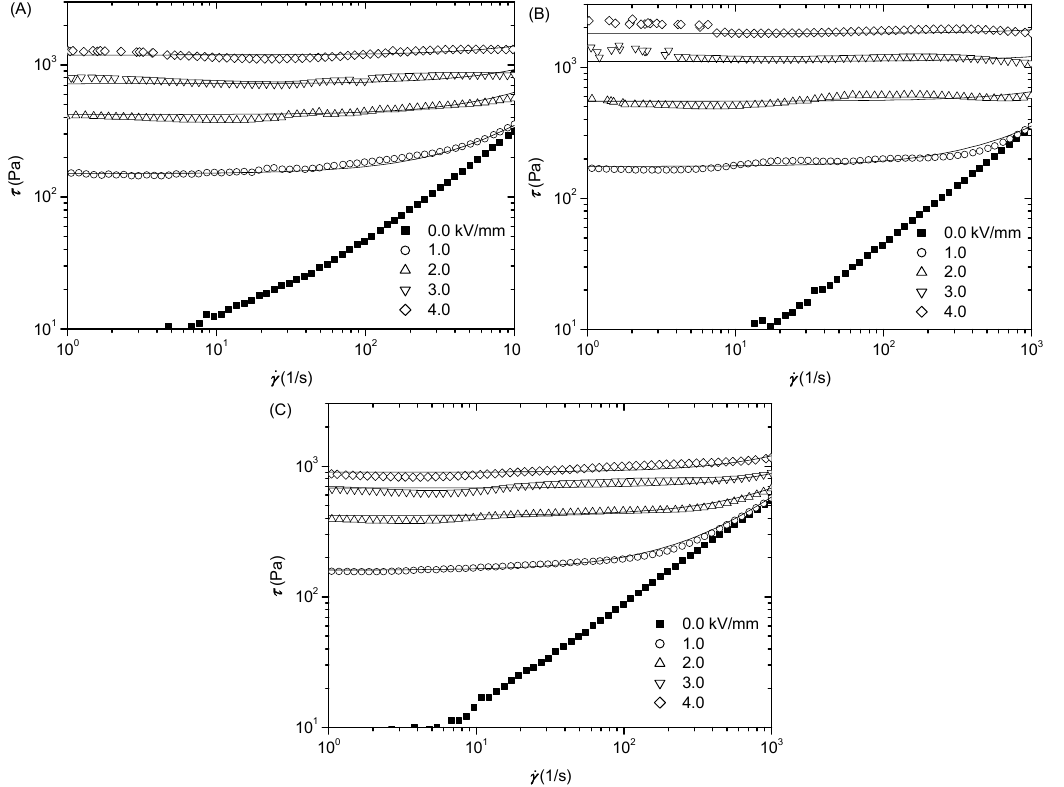
Figure 4. Flow curves of shear stress vs. shear rate for the electrorheological (ER) suspensions: ( A ) P[VBTMA][PF 6 ]; ( B ) P[VBTMA][PF 6 ]-c-PANI (40 wt %); ( C ) PANI ( φ = 27 vol %, T = 23 °C).